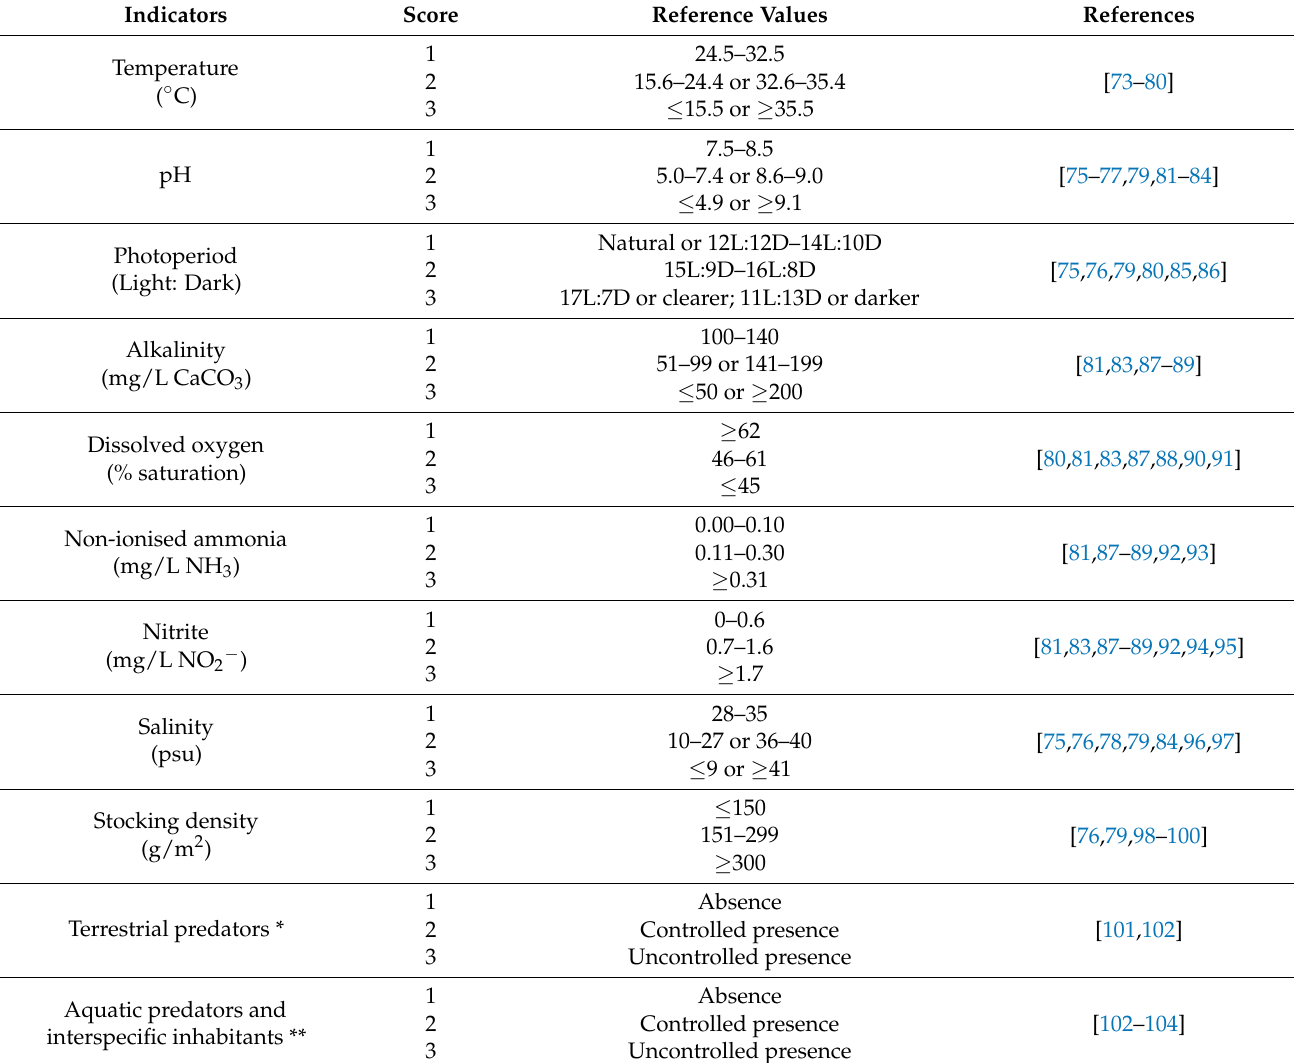
Table 2. Environmental indicators for Penaeus vannamei breeders.